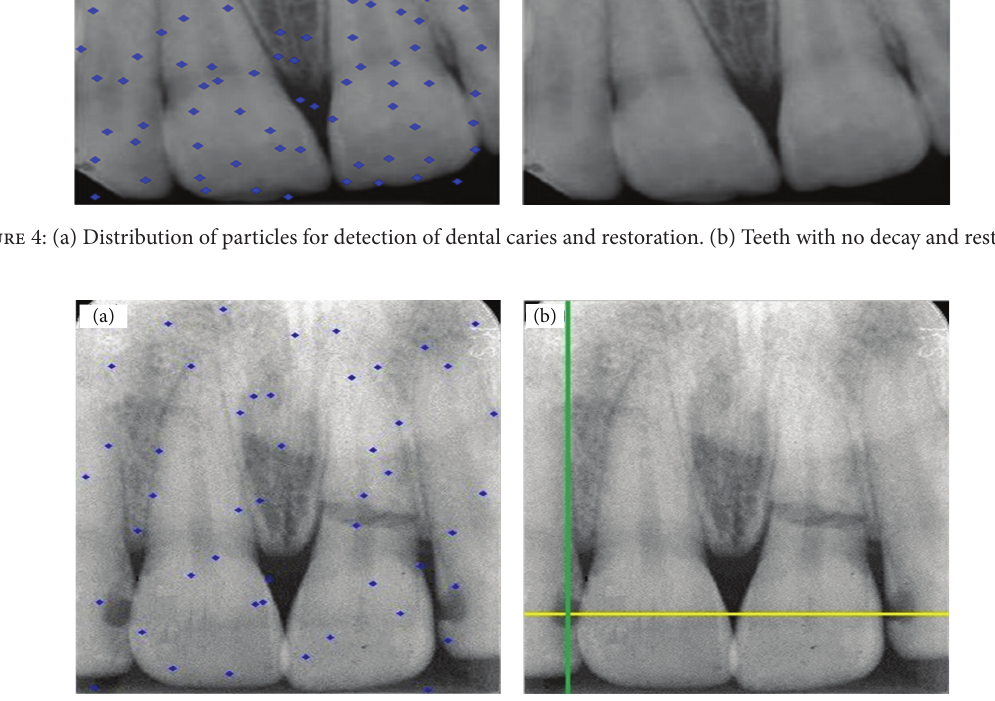
Figure 5: (a) Distribution of particles for detection of carious lesion and restoration. (b) Detection of one tooth with decay (right) depicted by green line crossed with yellow line.